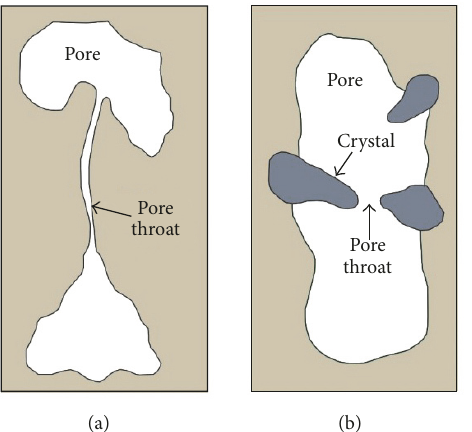
Figure 1: A sketch diagram of pore and pore throat in rock salt. (a) demonstrates two pores connecting with a pore throat; (b) displays a pore throat within a single